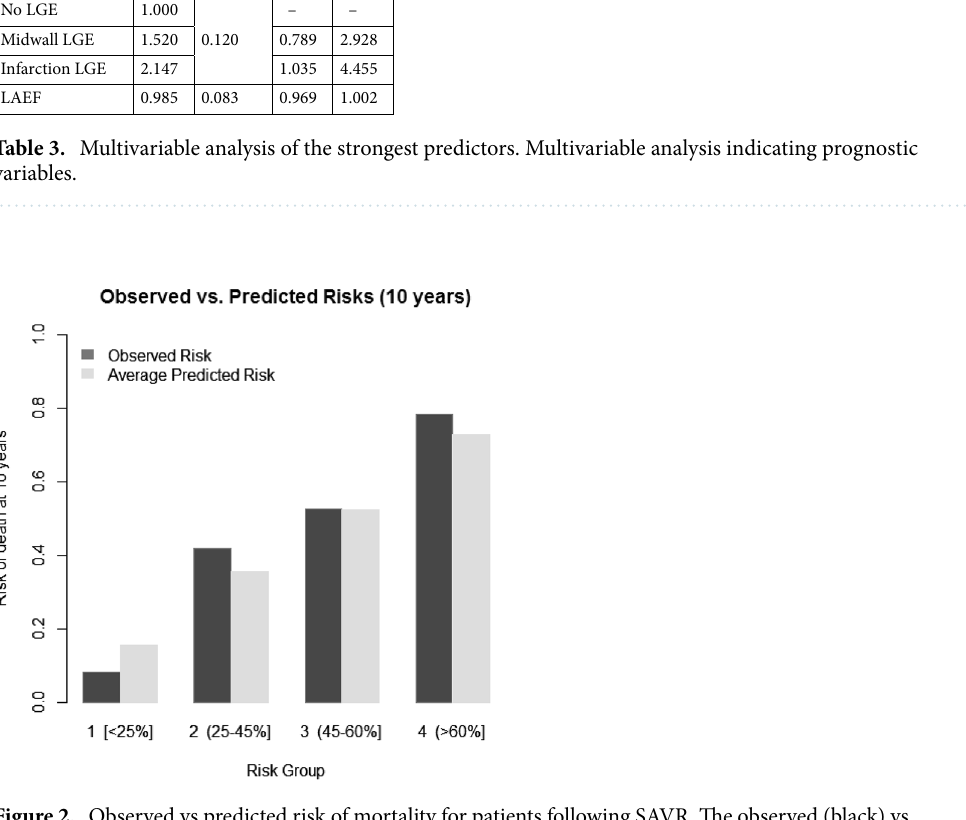
Figure 2. Observed vs predicted risk of mortality for patients following SAVR. The observed (black) vs predicted (grey) risk of mortality for patients following SAVR out to 10 years in clinically relevant risk groups is shown, indicating good prediction for the model. Number of patients per risk group: 73, 94, 42 and 41 for risk groups 1, 2, 3 and 4,